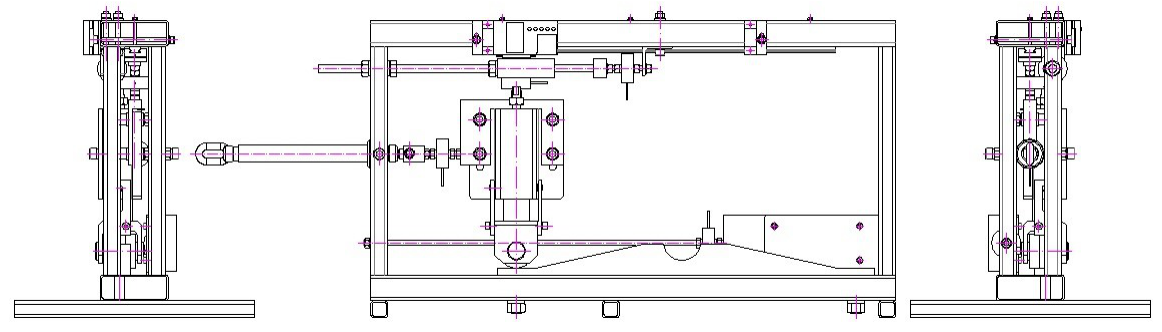
Figure 3: Testing equipment for the pallet arresting system